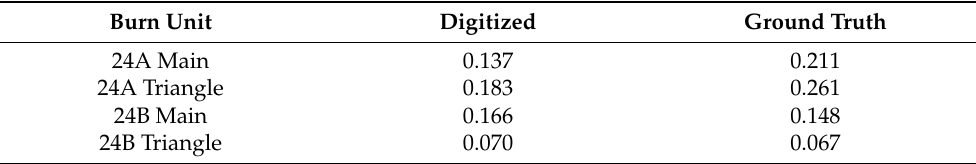
Table 2. Proportional area of sparkleberry found in burn plots at Ft. Jackson, SC, based on ground truth versus digitized estimates of percent shrub cover.